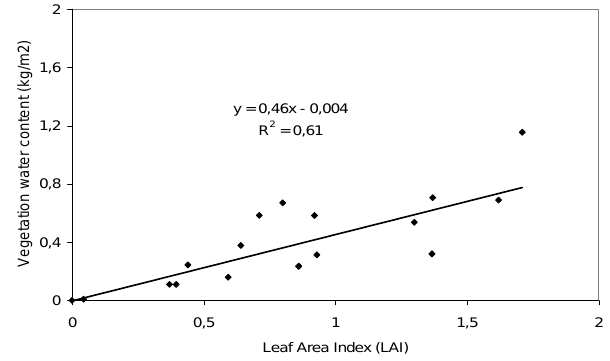
Fig. 9. Vegetation water content as a function of Leaf Area Index measured over wheat fields.